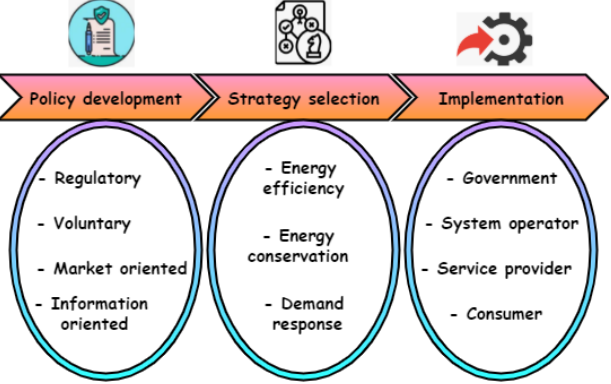
Figure 1. Demand-side management.